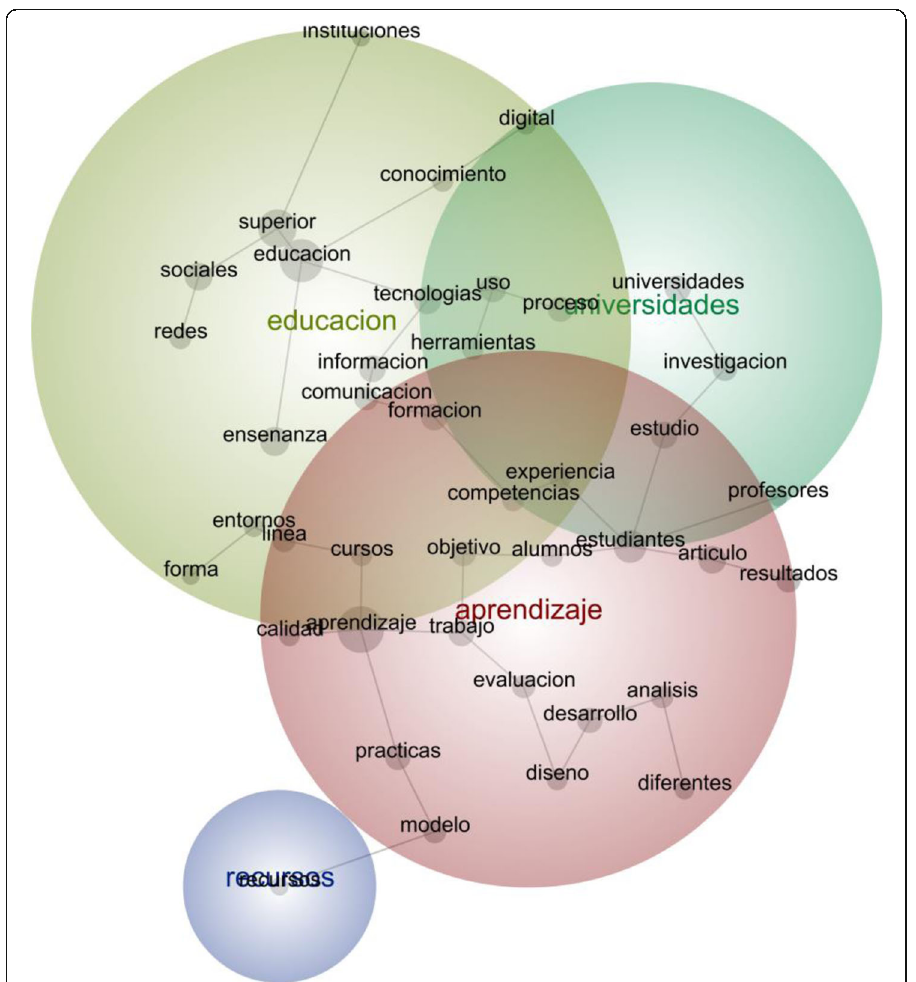
Fig. 2 Themes in the RUSC/ETHE journal between 2010 and 2015 (bilingual Spanish & English articles) ( n